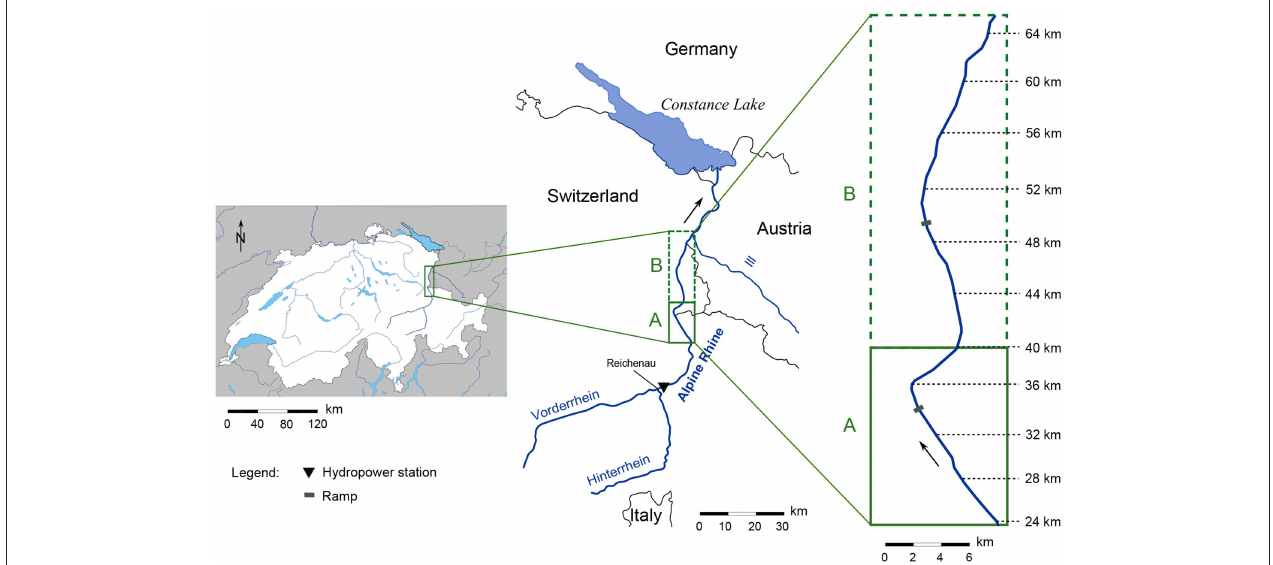
FIGURE 1 | Map of the Alpine Rhine river and the studied reach between Landquart (Switzerland) and the Ill river confluence. The reach can be divided into two sub-reaches, A and B, which have different alternate bar morphology. Maps were obtained from d-maps.com and SwissTopo (2018). Distances along the reach are reported following the official Rhine